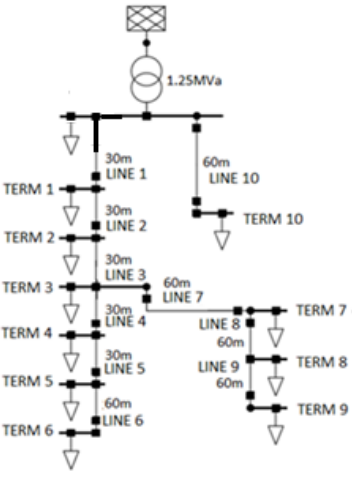
Figure 2. Single-line diagram of LV network based on the CIGRE benchmark grid showing 10 termi- nals with individual loads representing different numbers of houses and charging locations [8,17].